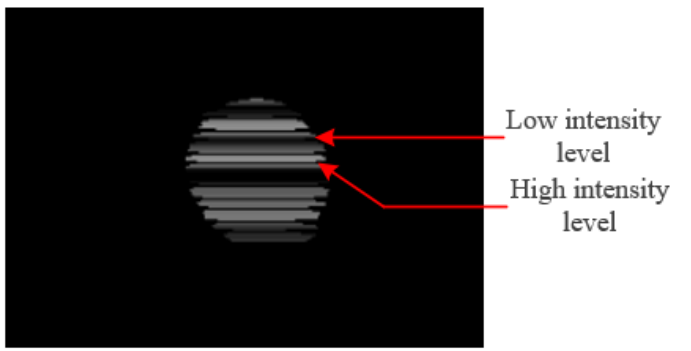
Figure 12. Received stripe patterns in the camera receiver.